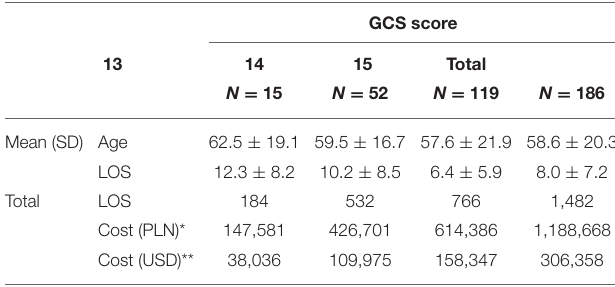
TABLE 3 | Age, length of stay and cost of stay in all patients with mTBI regard to GCS